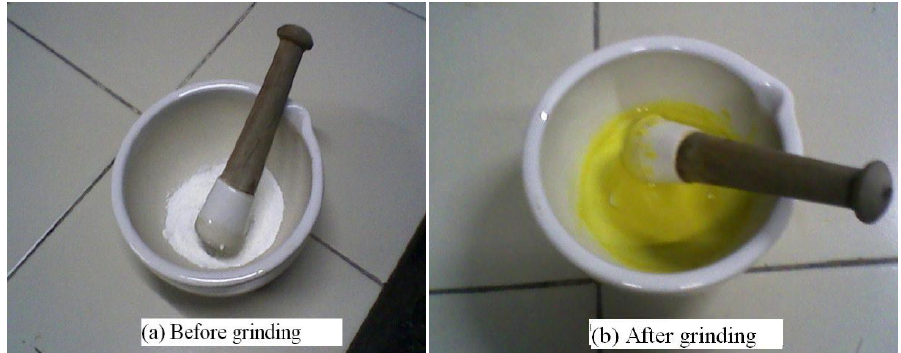
Figure 1. Photographs of the reaction mixture in mortar showing color transition taking place during reaction indicating the progress of